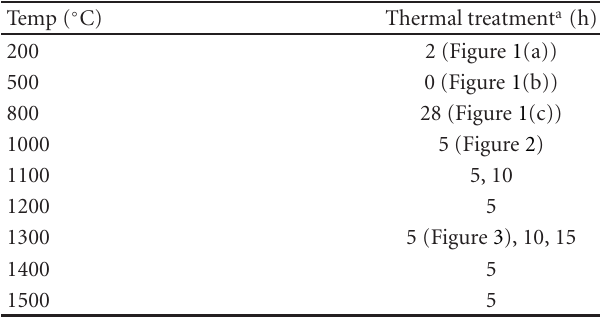
Table 1: Thermal treatments done to all four Ba-exchanged zeolite A samples and the figures in which the corresponding XRD patterns are shown.